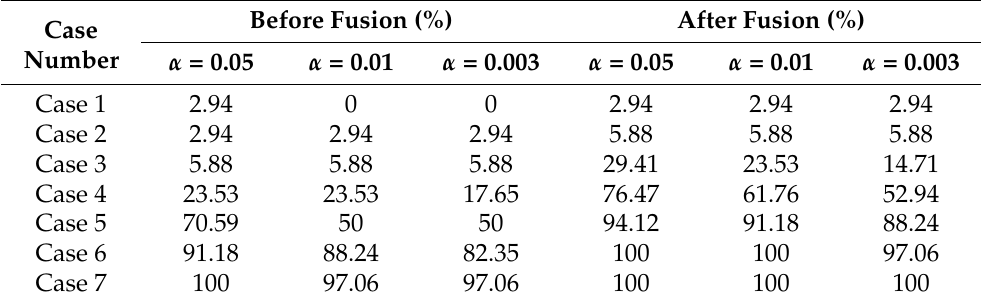
Table 8. Warning rates for the performance degradation that occurred in the mid-span.